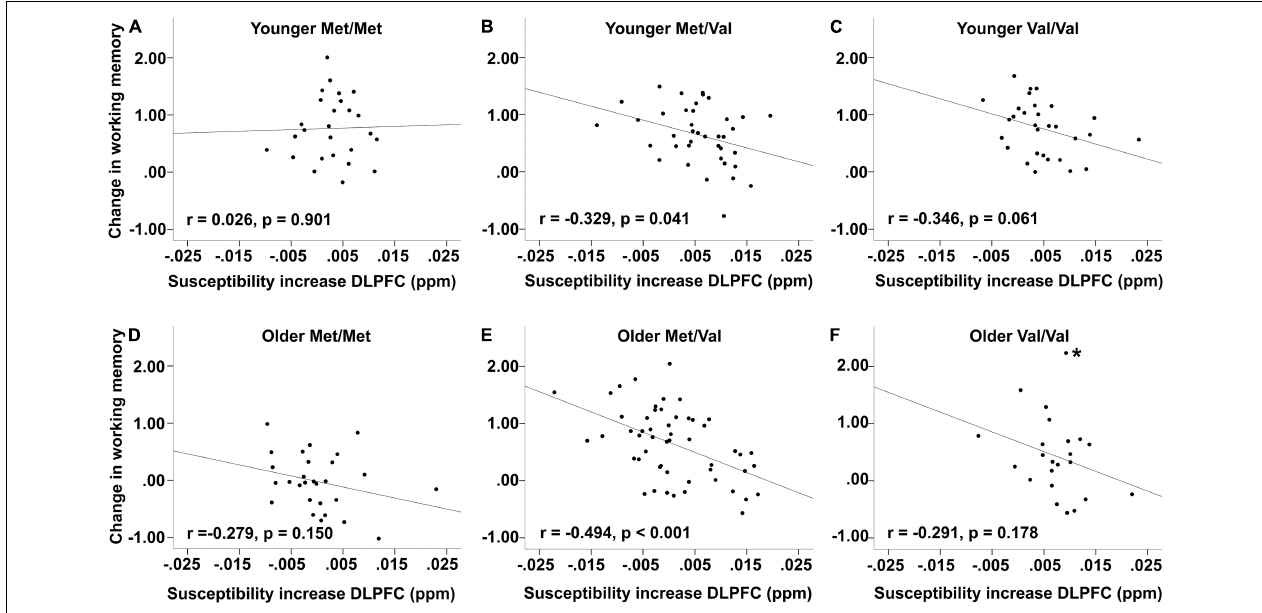
FIGURE 4 | Association between changes in working memory and iron accumulation [susceptibility increase in parts per million (ppm)]. Top row: Younger (A) Met/Met, (B) Met/Val, and (C) Val/Val carriers. Bottom row: Older (D) Met/Met, (E) Met/Val, and (F) Val/Val carriers. Plots are based on imputed factor scores. * indicates marginal multivariate outlier whose exclusion led to a marginally significant association (see